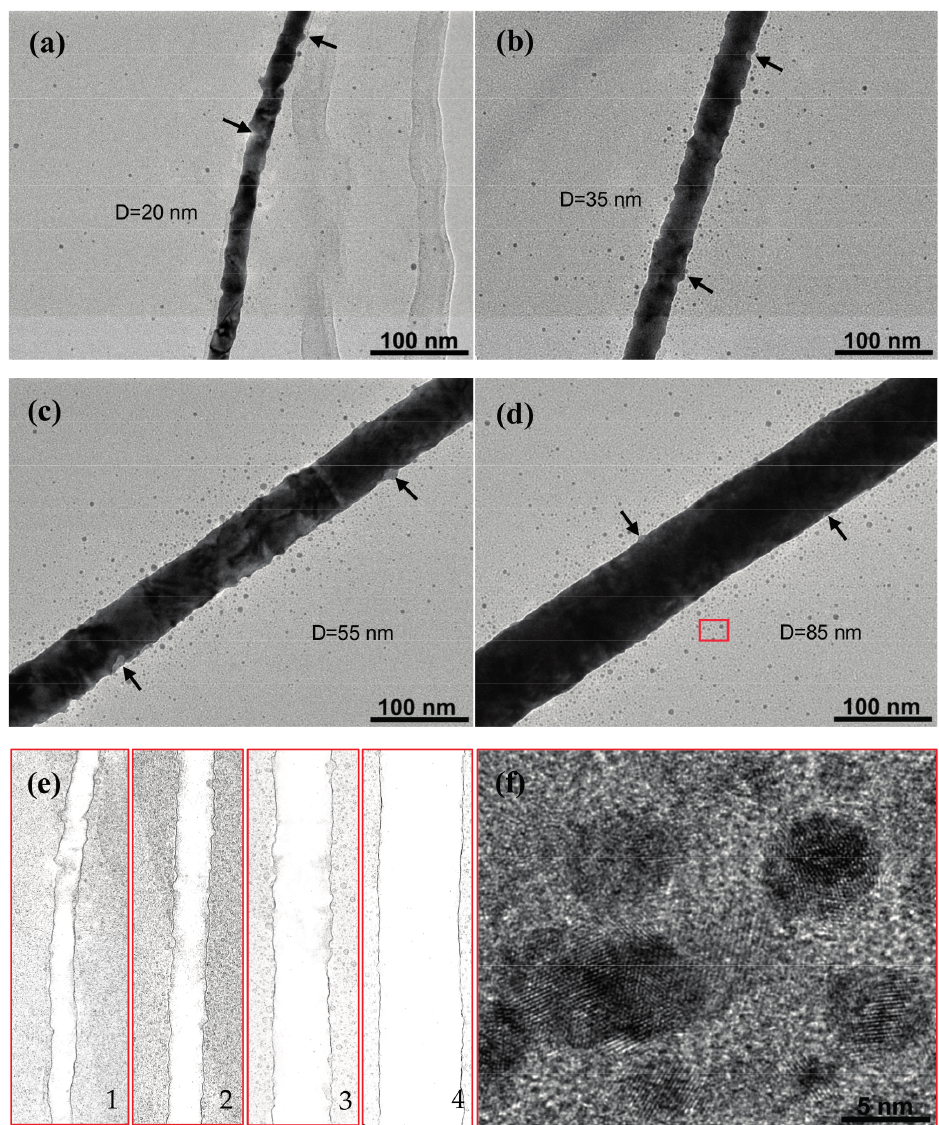
Figure 2. TEM images of gold NWs after ion irradiation with 1.4 MeV Xe ions, at a fluence of 1 × 10 14 ions cm − 2 . The diameters of these NWs are ( a ) 20 nm, ( b ) 35 nm, ( c ) 55 nm, and ( d ) 85 nm, respectively. Black arrows point out products on NWs. ( e ) 1, 2, 3, and 4 show the contour of irradiated gold NWs in ( a – d ), separately. ( f ) High-resolution transmission electron microscopy (HRTEM) image of sputtered NPs of rectangular region in ( d